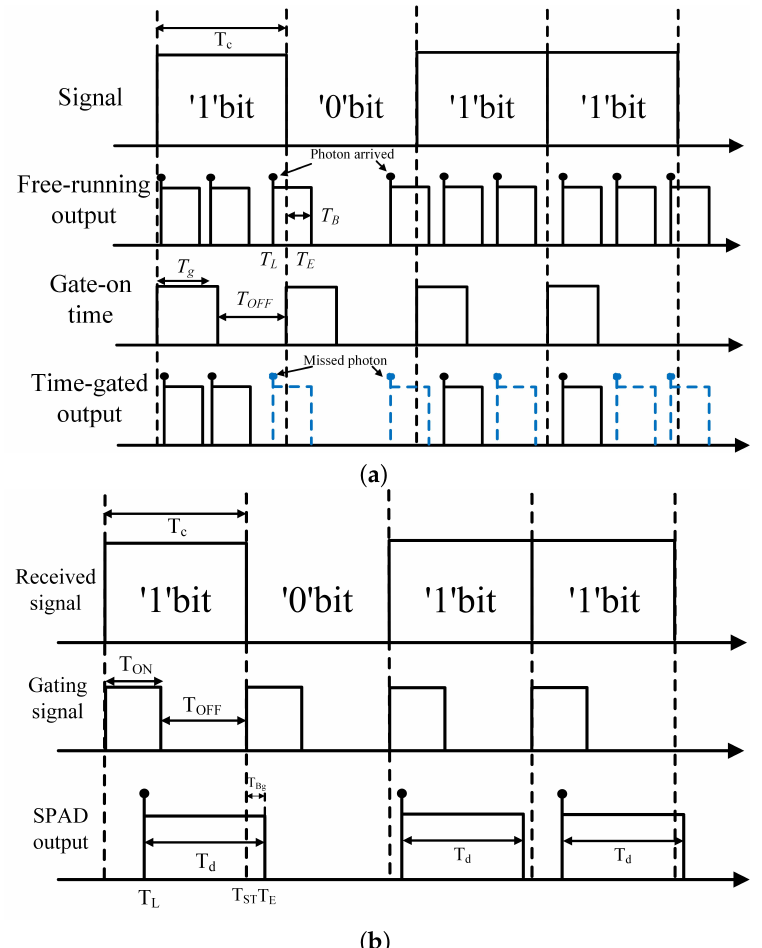
Figure 1. The output characteristics of free-running mode and time-gated mode. ( a ) Free-running AQ-SPAD and time-gated AQ-SPAD. ( b ) The output of time-gated SPAD. (If the gate-OFF time is less than dead time, ISI distortion may occur in